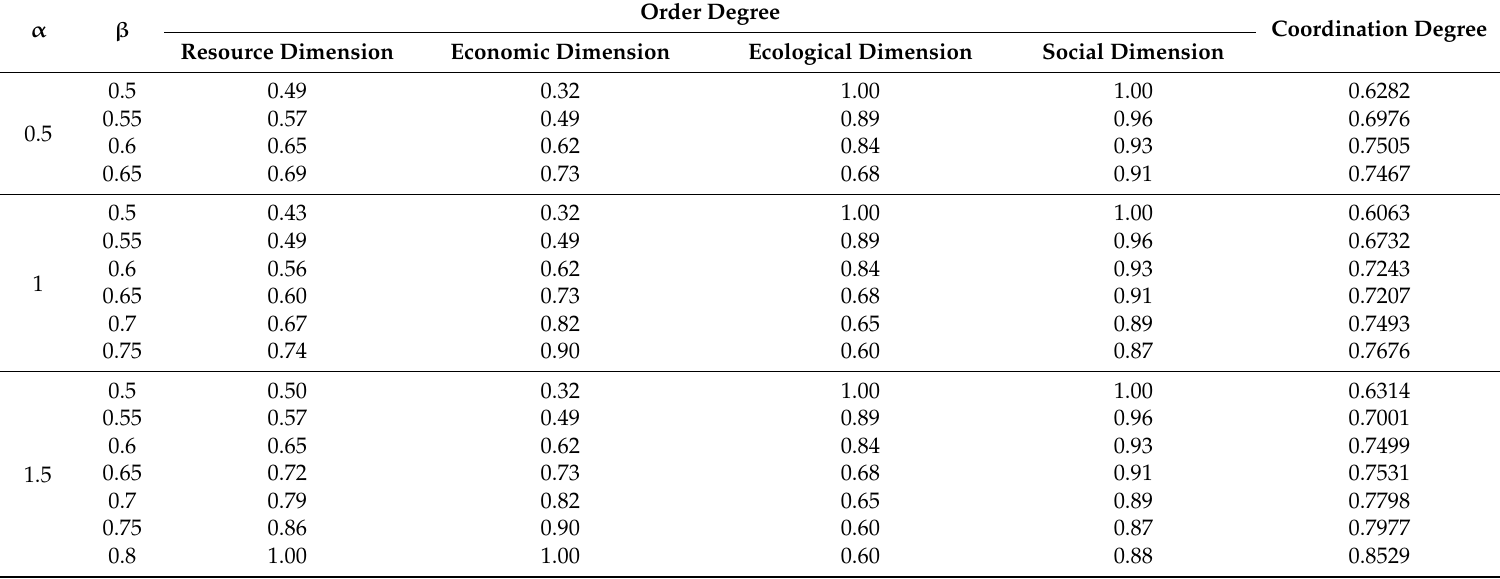
Table 5. Multi-dimensional regulation results under different